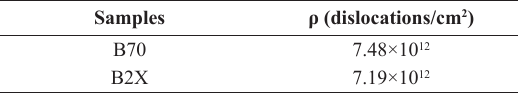
Table 3. Dislocation density (ρ) obtained through XRD for the B70 and B2X